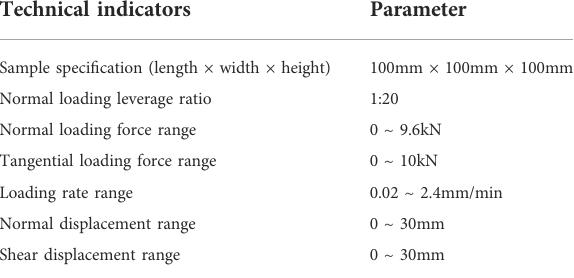
TABLE 1 Technical indicators of the